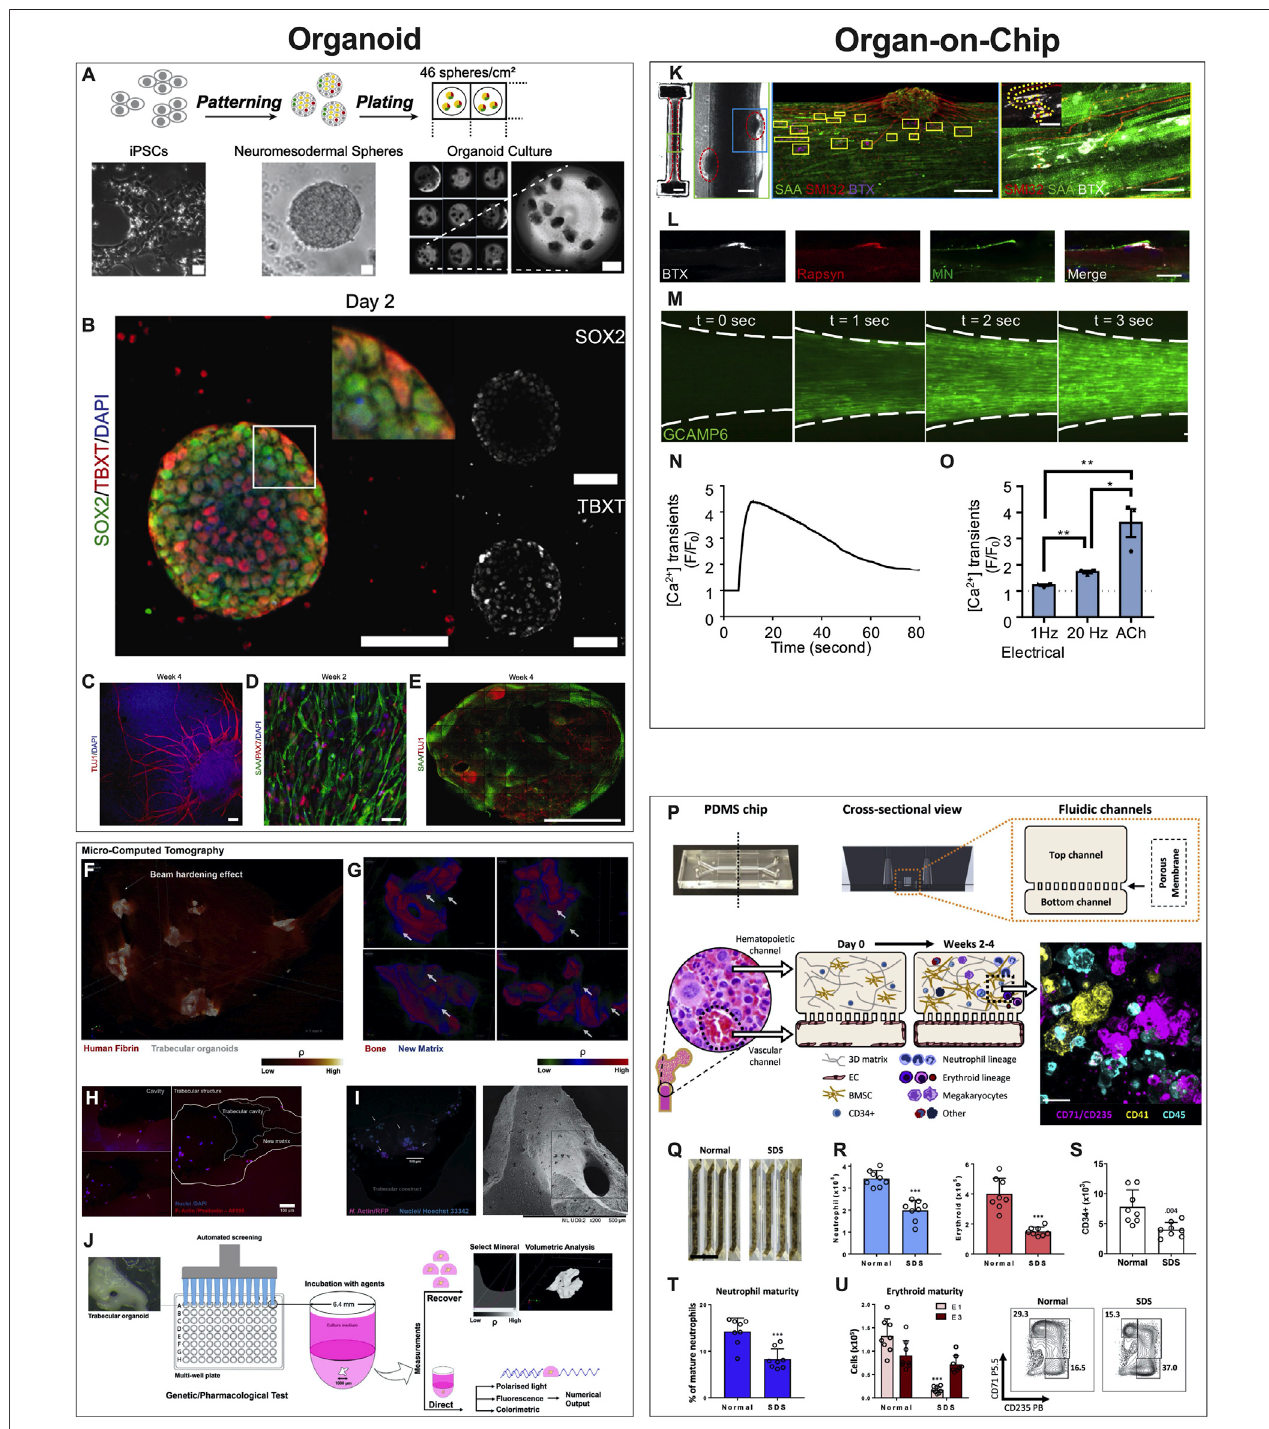
FIGURE 3 | Examples of Organoids and Organ-on-a-Chip Microphysiological Systems. (A – E) Human sensorimotor organoid model uses iPSCs cultured in suspension and allowed to self-assemble into organoids and mature in culture over several weeks (A) , with immunostaining for neuronal stem cell (TUJ1), myogenic (TBXT, PAX7), neuromesodermal (SOX2/TBXT), and neurogenic (SOX2) transcription factors and the sarcomeric α -actinin (SAA) (B – E) . The platform was used to test several ALS traits and their effect on the NMJ, elucidating key events and attributes of motor neuron diseases. [Reproduced from (Pereira et al., 2021) with permission]. (F – J) Trabecular bone in fi brin gel organoids (F) demonstrating bone remodeling in vitro (G) via the coupled activities of osteoblasts (H) and osteoclasts (I) . This human trabecular bone organoid allows for detailed morphologic and resorption events to be studied and chemically characterized (J) , including investigating